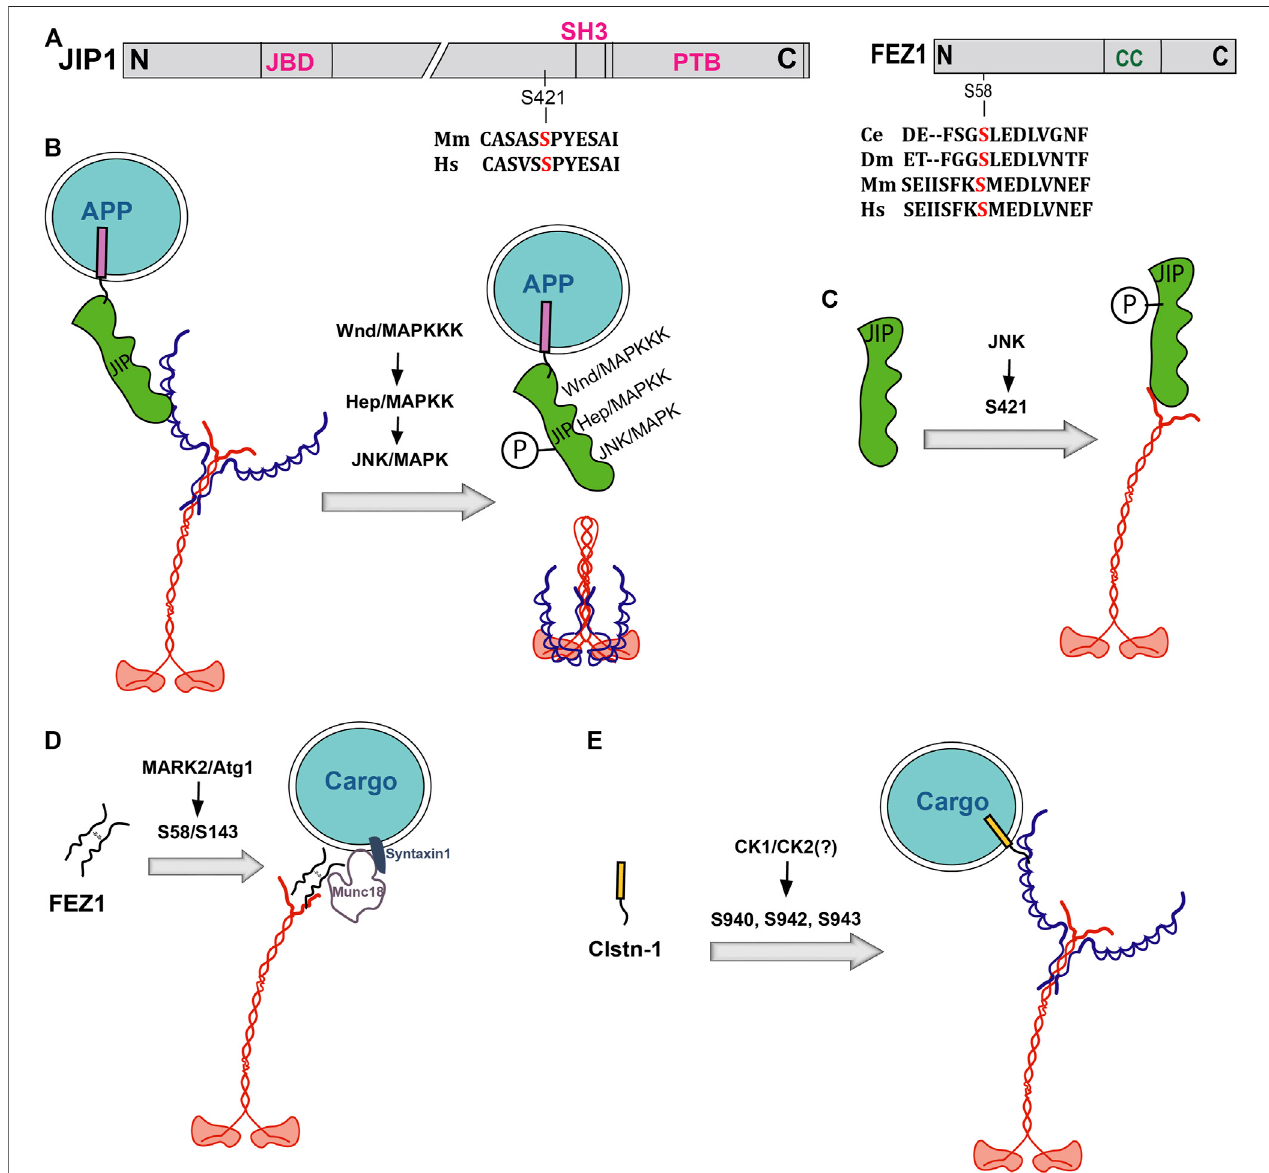
FIGURE 2 | Effect of phosphorylation on Kinesin-1 adaptors. (A) Domain organizations of JIP1 and Fez1 with relative positions of phosphorylation sites and alignments of the surrounding amino acid sequences from different species. Ce, Dm, Mm and Hs represent C. elegans , Drosophila , mice, and humans. (B – D). Schematics depict how phosphorylation of JIP1 and Fez1 affect the adaptor binding to the kinesin motor. JIP1 is phosphorylation by Hep and JNK downstream of MAPKKK signaling at some unknown site(s) disrupts association with KLC (B) . On the other hand, JIP1 phosphorylation by JNK at S421 enhances binding to the KHC tailand promotes APPvesicletransportinDRG neurons (C) .Similarly, phosphorylationofboth the humanand Drosophila Fez1at S58/S143 byMARK2 and Atg1, respectively, enhances its binding to Kif5C/KHC tail and the Munc18-Syntaxin1 complex (D) , and that of Alc α /Clstn1, potentially by CK1 and/or CK2, increases KLC association (E)